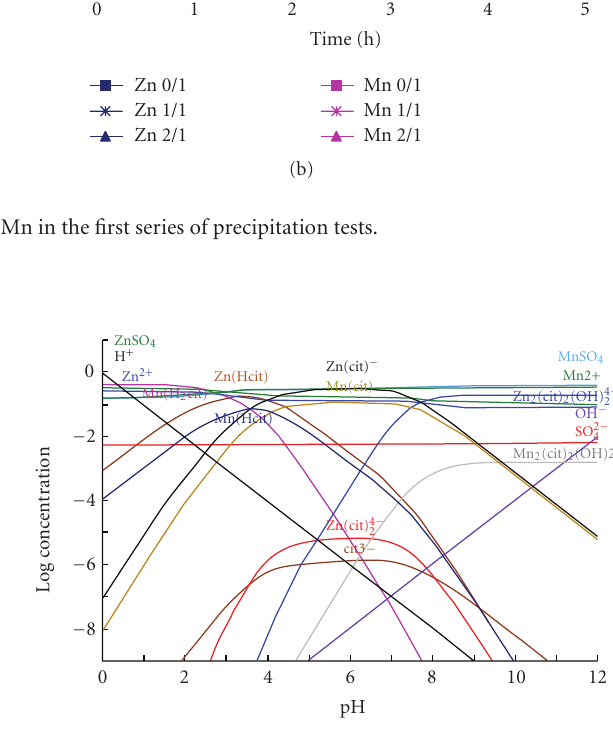
Figure 7: Solubility diagram of manganese, zinc, and citrate